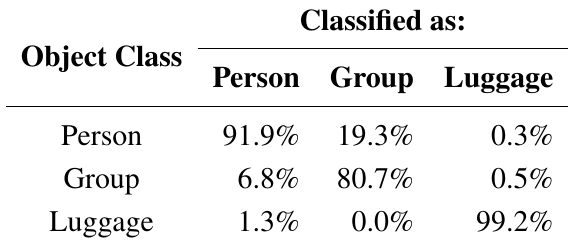
Table 1. Classification results obtained with the implemented software during a real